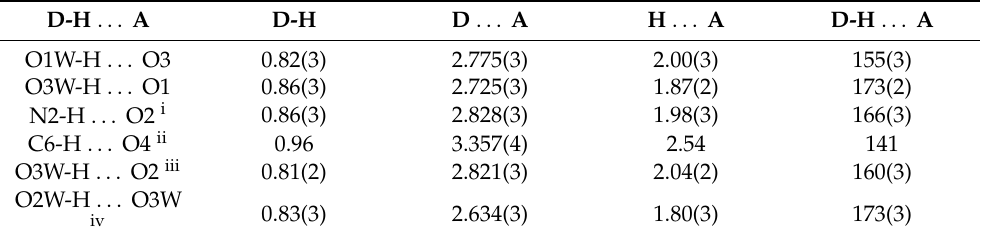
Table 3. Hydrogen bonding parameters (Å, ◦ ) in complex ( 1